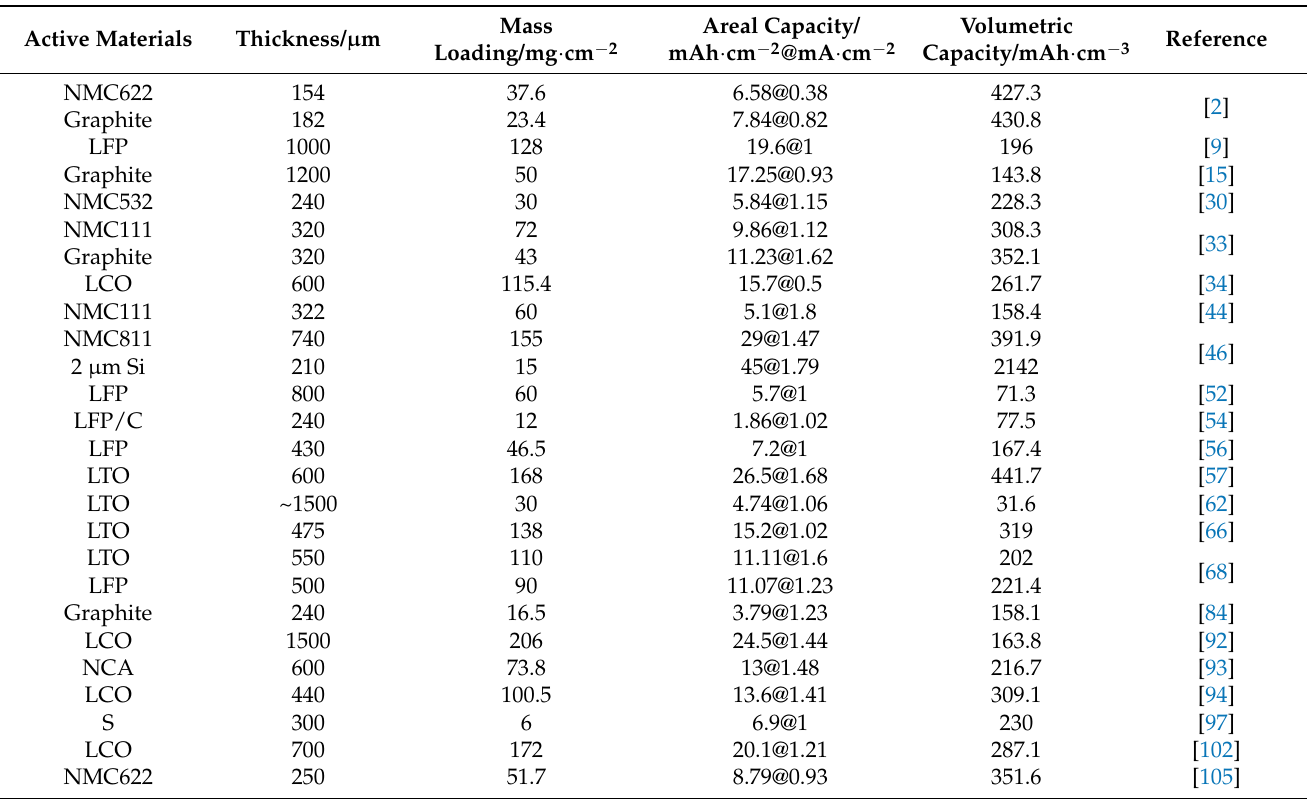
Table 1. Summary of recently reported thick